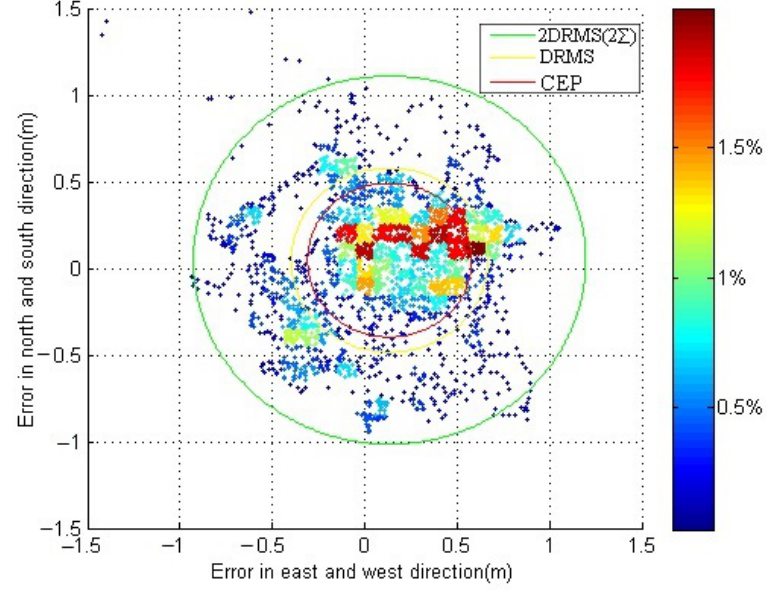
Figure 8. Scatter plot of the position errors for the static positioning experiment.